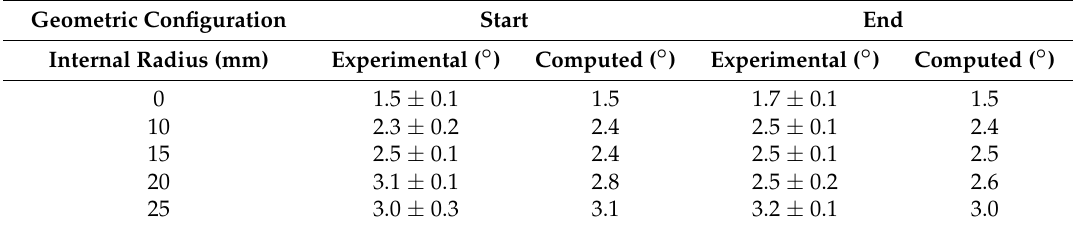
Table 2. Multiple circular scanning path: bending angle at the start and end points of the free edge of the plate after five irradiations for the studied